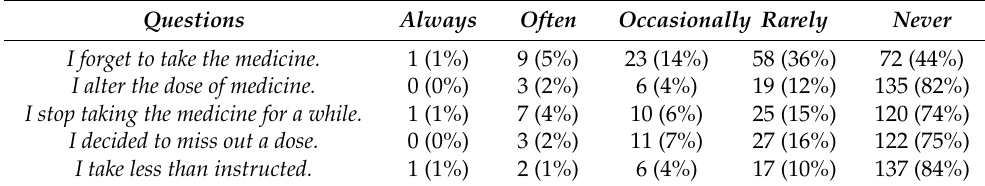
Table 3. Distribution of adult responses in MARS